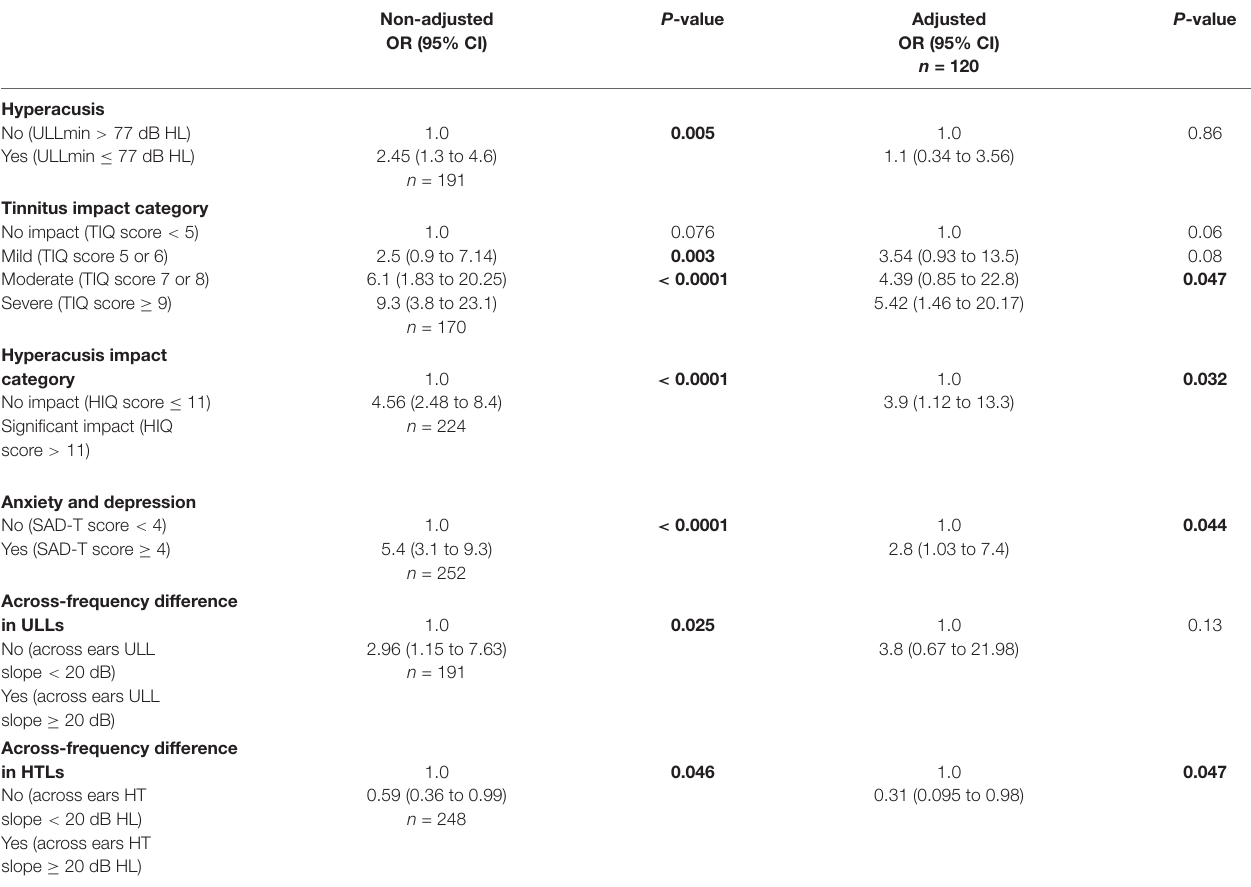
TABLE 5 | Results of a logistic regression model showing the odds ratio (OR) of the SSSQ4 score (dependent variable) relative to a baseline.